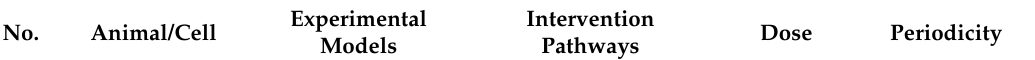
Table 3. Health effects of taurine on the retina and the need for